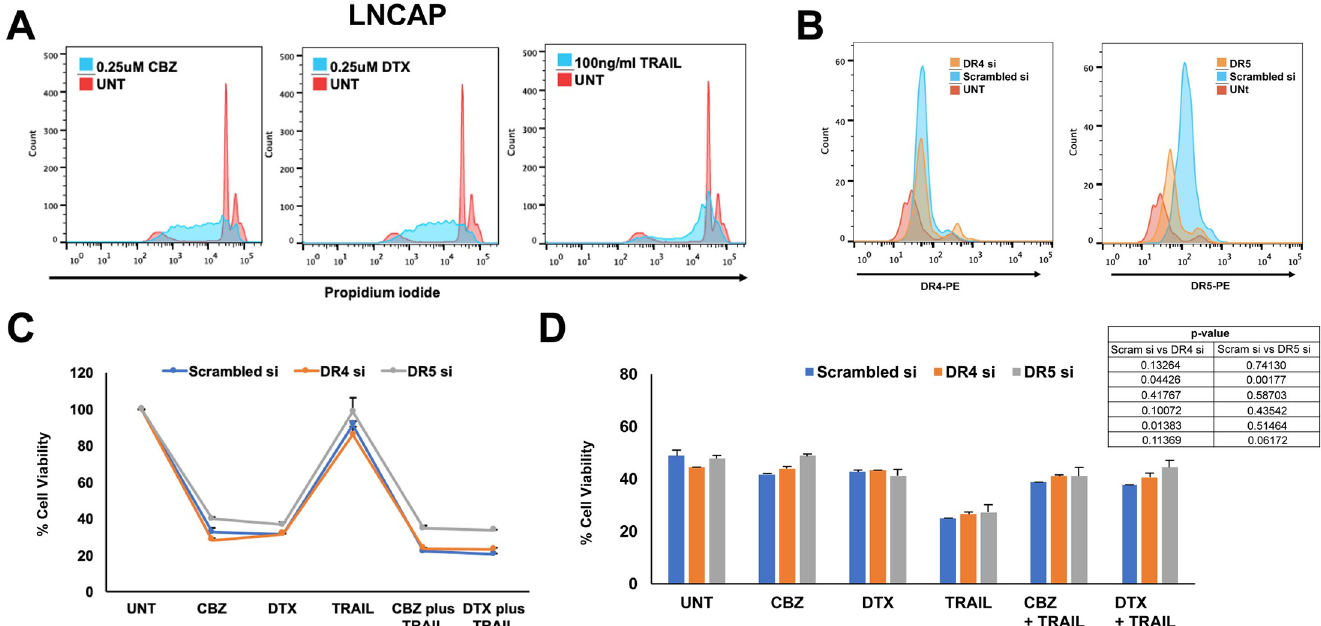
Fig 2. Synergistic effect of taxane + TRAIL treatment in LNCaP cells with DR4 and DR5 knockdown in 2D cell culture. A . Representative propidium iodide histograms of LNCaP cells treated with either 0.25 μ M CBZ, 0.25 μ M DTX, or 100 ng/mL TRAIL. B . Representative histograms of death receptor expression of DR4 and DR5 siRNA knockdown compared to scrambled and untreated controls. C . Cell viability of LNCaP cells after DR4 and DR5 knockdown when treated with 0.25 μ M CBZ, 0.25 μ M DTX, 100 ng/mL TRAIL, CBZ + TRAIL, or DTX + TRAIL and assessed via AlamarBlue assay. D . Cell viability of LNCaP cells after DR4